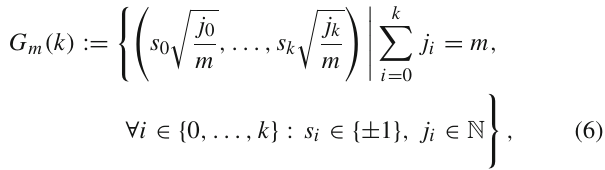
Group Order Elements D 4 8 ± 1 , ± i , ± j , ± k T 24 All sign combinations of O 48 All sign combinations and permutations of (cid:5) 120 All sign combinations and even permutations of